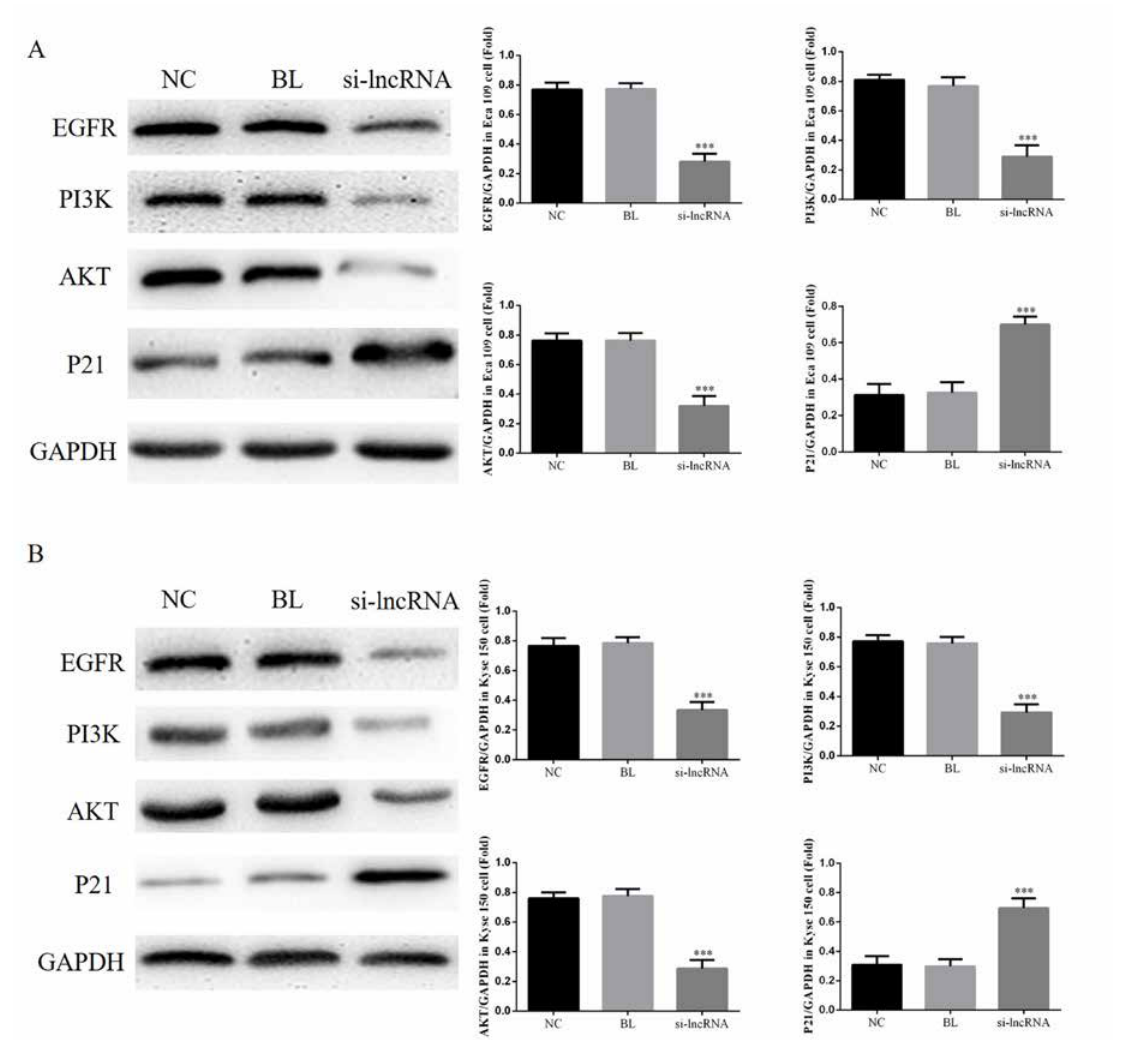
Figure 5. The relative proteins expressions of difference groups in Eca 109 and Kyse 150 cells. NC: Normal control group; BL: Blank group; si-lncRNA: si-lncRNA LINC00152 group A. The relative proteins expressions of difference groups in Eca 109 by WB assay. ***: P<0.05, compared with NC group. B. The relative prote- ins expressions of difference groups in Kyse 150 by WB assay. ***: P<0.05, compared with NC